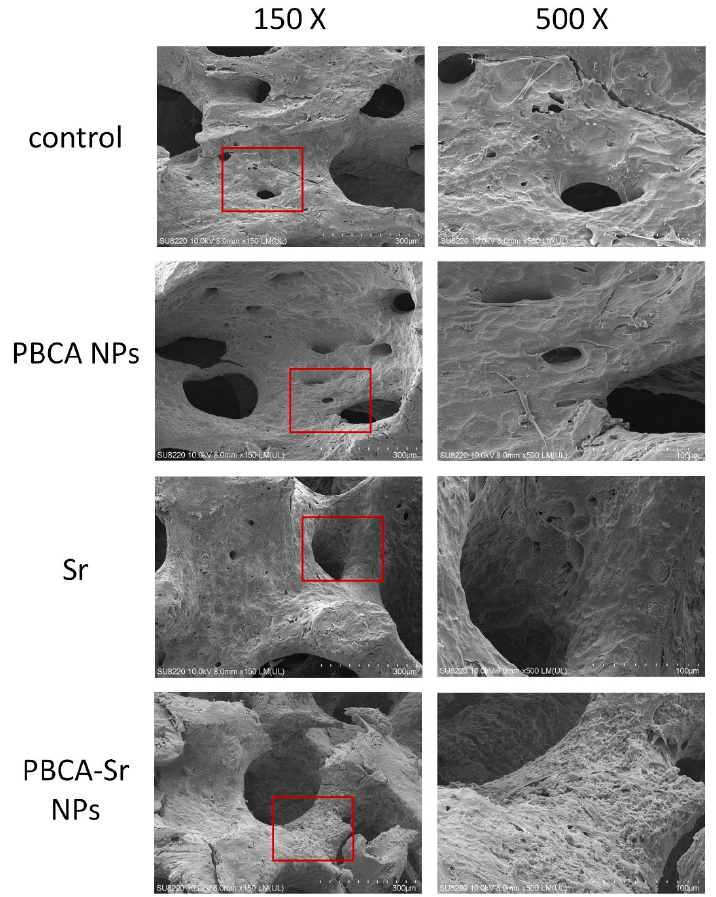
Figure 7. FE-SEM images of committed MSCs in procaine mandible bone block. Cells were treated with PBCA NPs (50 μ g/mL), strontium ranelate (0.1 mM) or PBCA-Sr NPs (50 μ g/mL containing 0.1 mM Sr) for 7 days. Areas highlighted in the red square are displayed under higher magnifica- tion on the right side. Magnification: 150× and 500×.